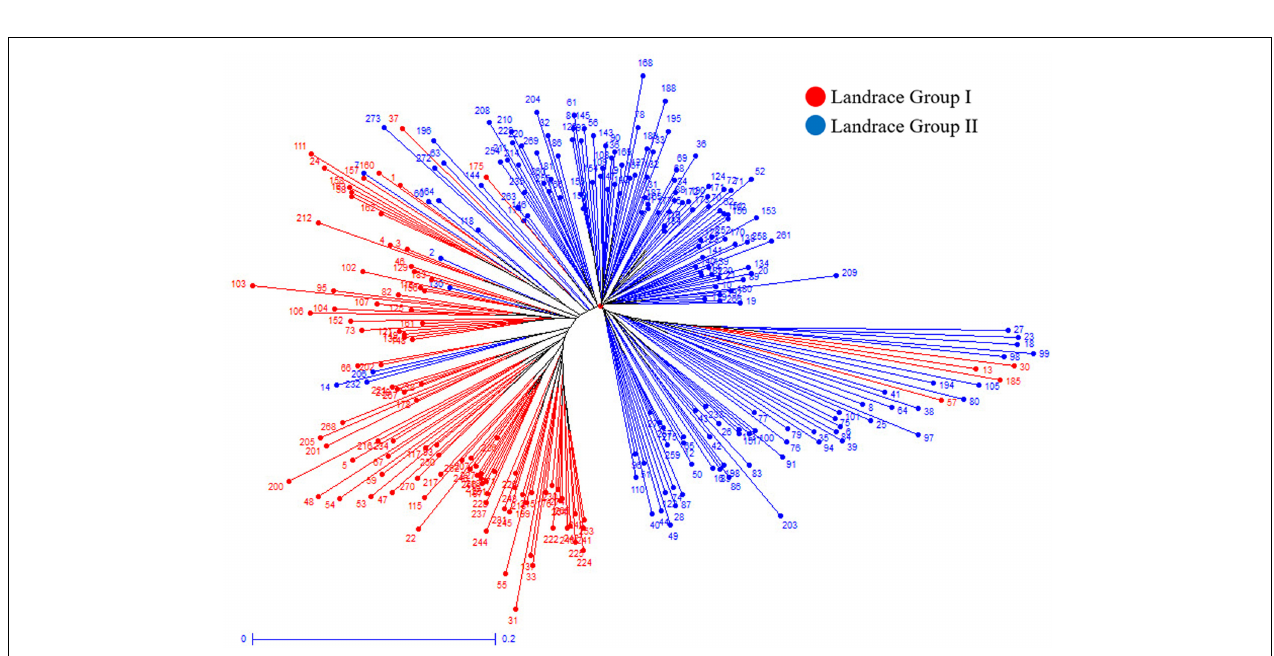
FIGURE 9 | Weighted neighbor-joining clustering dendrogram generated using 16,506 SNPs and 270 Iranian wheat landraces to show the relationship between the groupings from cluster analysis and structure analysis (separation by color).